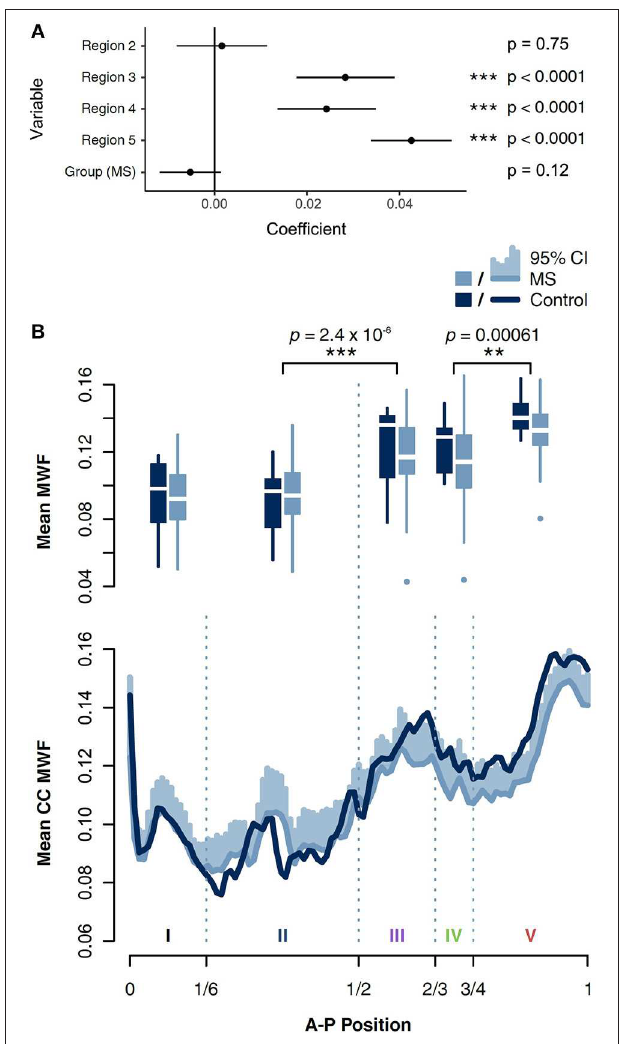
FIGURE 4 | (A) MWF was found to vary significantly by corpus callosal region using a multivariate generalized estimating equations (GEE) model. MWF was lower in MS than in controls, but this finding did not reach statistical significance. Likelihood ratios are shown relative to their difference from control group, region 1. (B) Boxplots of MWF in five regions of the CC in individuals with MS and controls. Significant differences based on Tukey’s range test between adjacent regions are shown. MWF averaged in voxel-thick vertical strips in each sagittal slice were interpolated linearly to 100 values between anterior and posterior ends, and then averaged across slices to obtain a CC MWF distribution for each subject. These distributions were then averaged across individuals with MS and controls separately, with 95% confidence intervals shown.